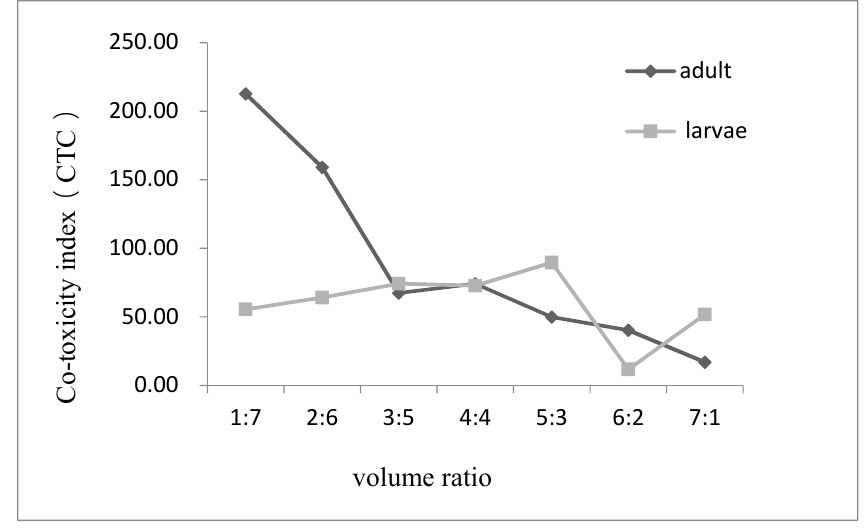
Figure 1. The CTC of contact activity of carvone and limonene at different ratios against adults and larvae of T. castaneum.